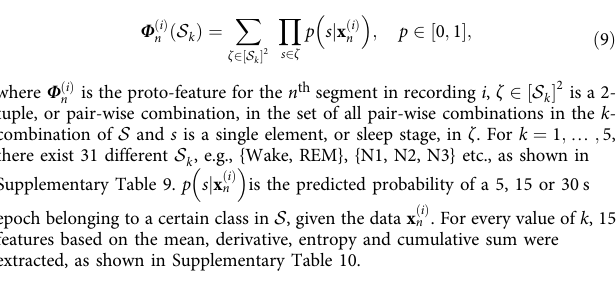
(cid:4) (cid:5) Supplementary Table 9. p s j x ð i Þ n is the predicted probability of a 5, 15 or 30 s